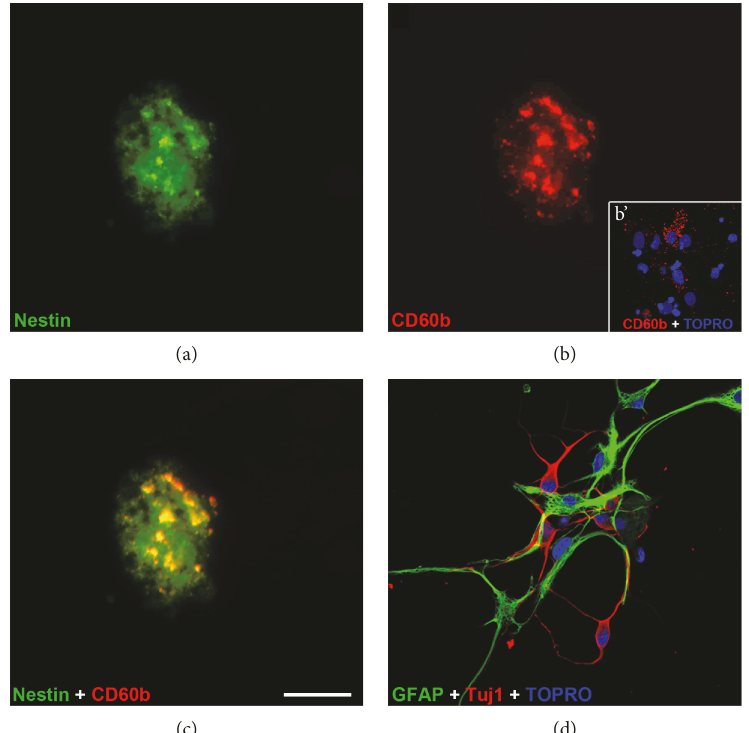
Figure 8: Characterization and di ff erentiation of neurospheres derived from CD60b-positive cells. Immunostaining of neurospheres derived from CD60b-positive cells (a – c). As expected, most of the cells inside the neurosphere express nestin (green); a subpopulation of these cells also expresses CD60b (red). Some cells di ff erentiated from neurospheres also expressed CD60b (b ’ ). (d) Di ff erentiation of neurospheres originated from CD60b-positive adult cells in GFAP-positive astrocytes (green) and TUJ1-positive neurons (red). Nuclei are stained with TO-PRO-3 in blue. Scale bar: 40 μ m (a – c); 46 μ m (b ’ ); 35 μ m